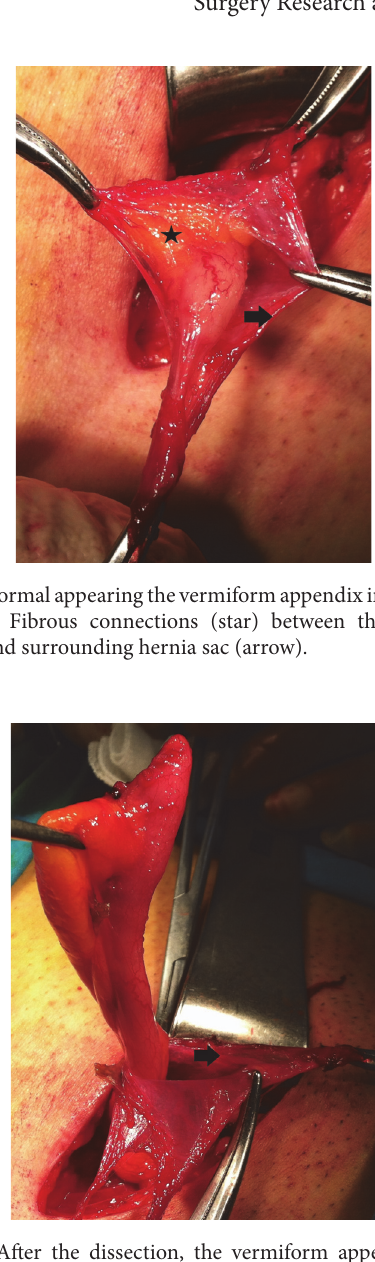
Figure 2: After the dissection, the vermiform appendix located within the inguinal hernia sac